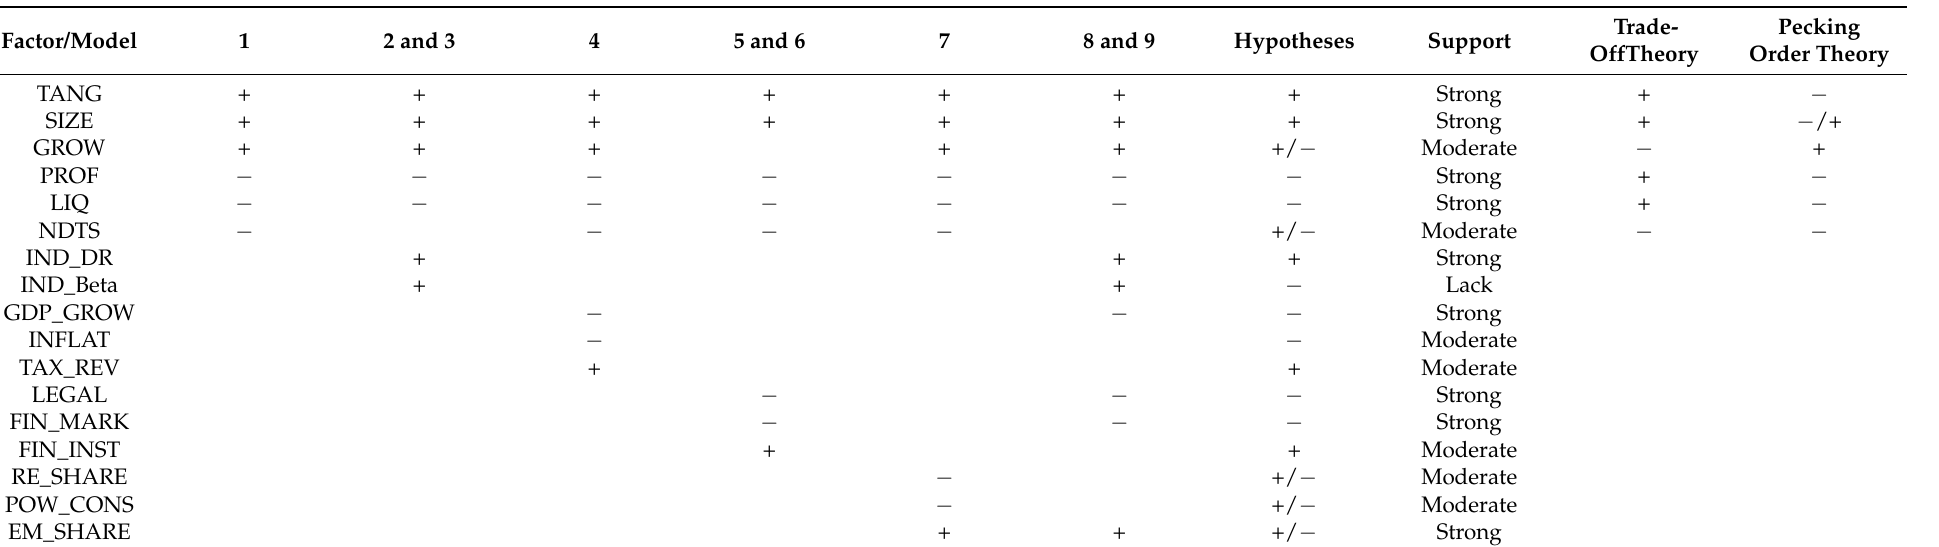
Table 4. Summary of